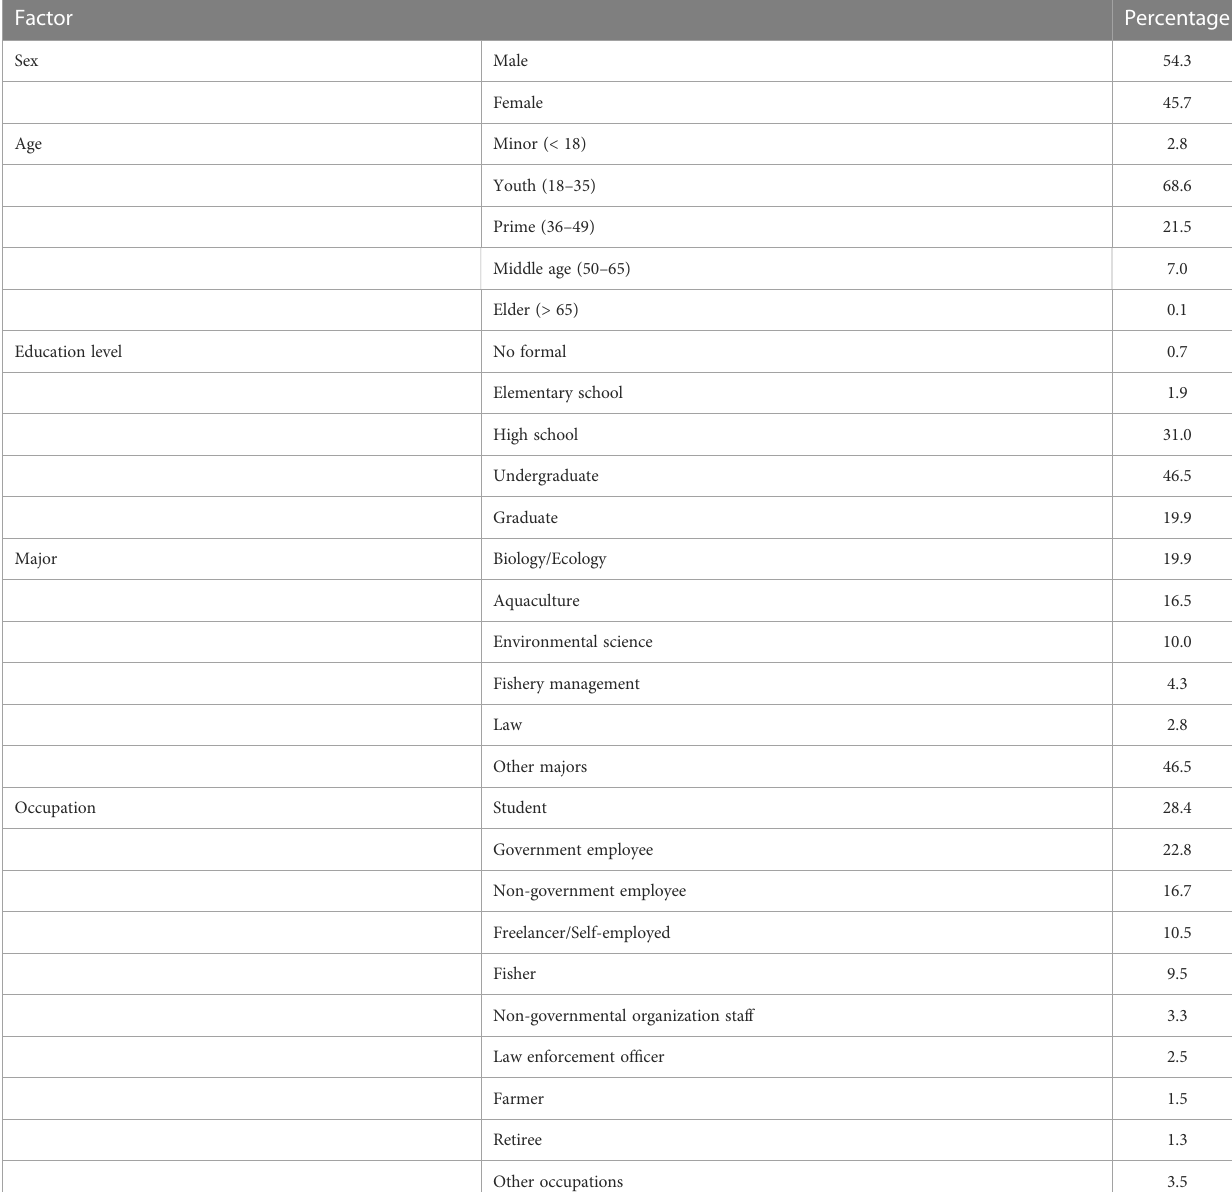
TABLE 1 Basic sociodemographic information of respondents (n =